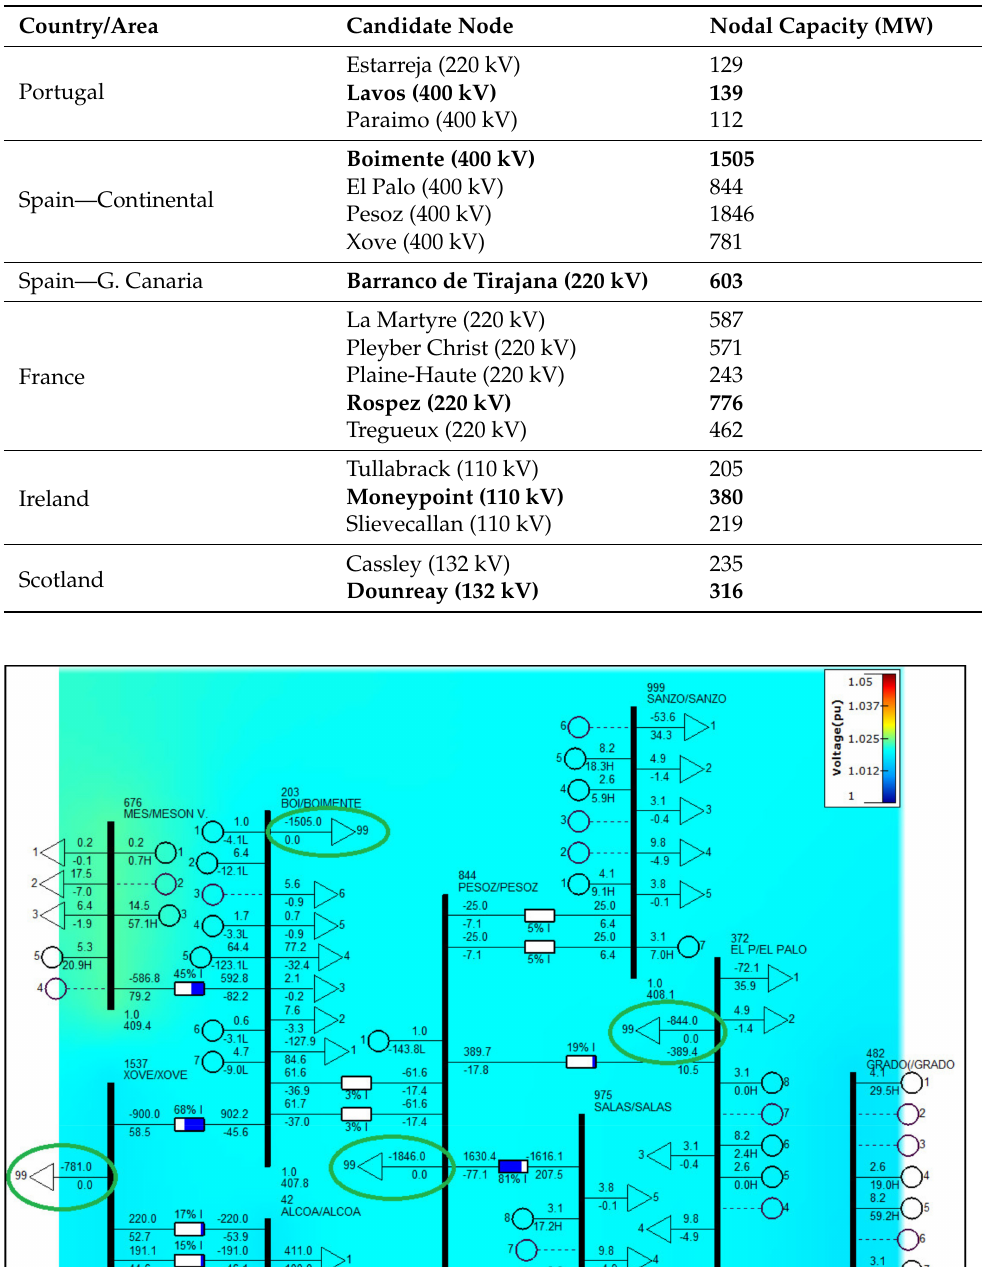
Table 5. Nodal capacity calculation results.